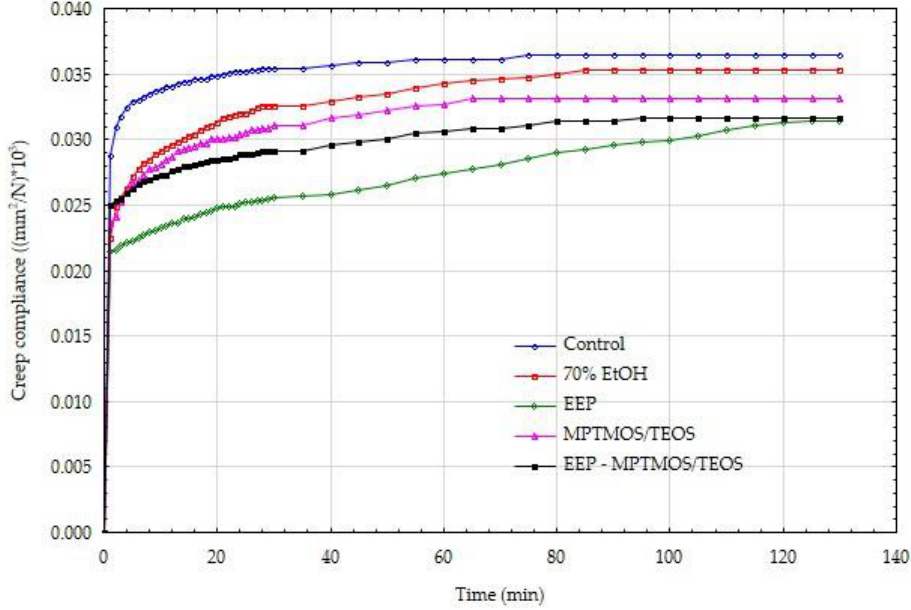
Figure 3. Creep compliance of dry wood, protected by various means.